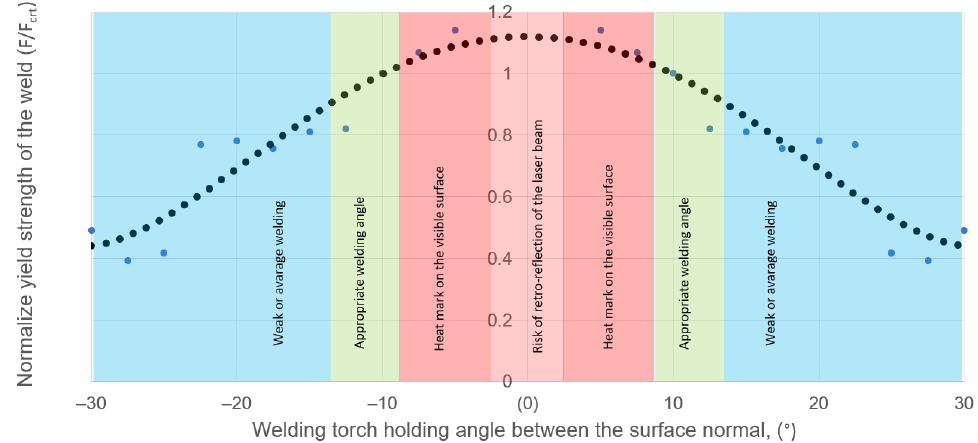
Figure 7. Normalized yield strength of the weld versus laser torch holding angle and welding qual ‐ ity mapping.